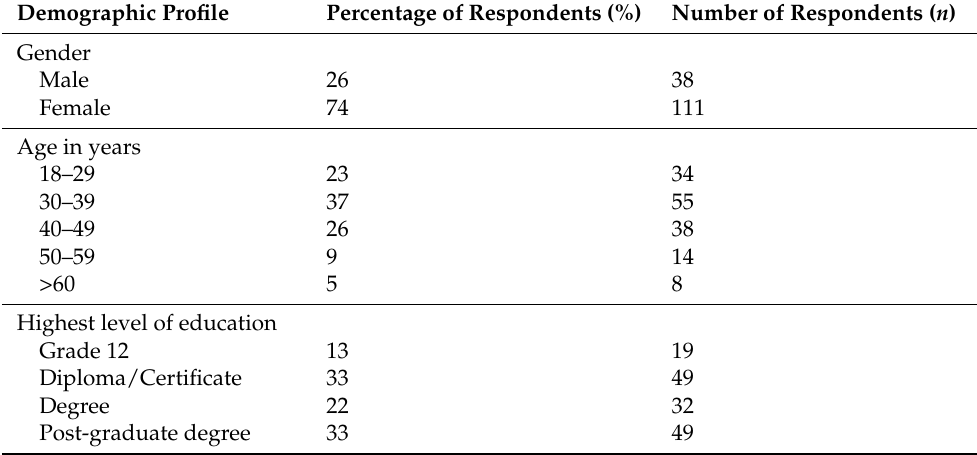
Table 1. Descriptive demographic profile ( n =